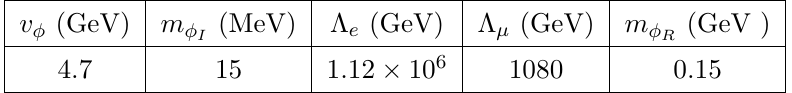
anomalies. e=(cid:22)